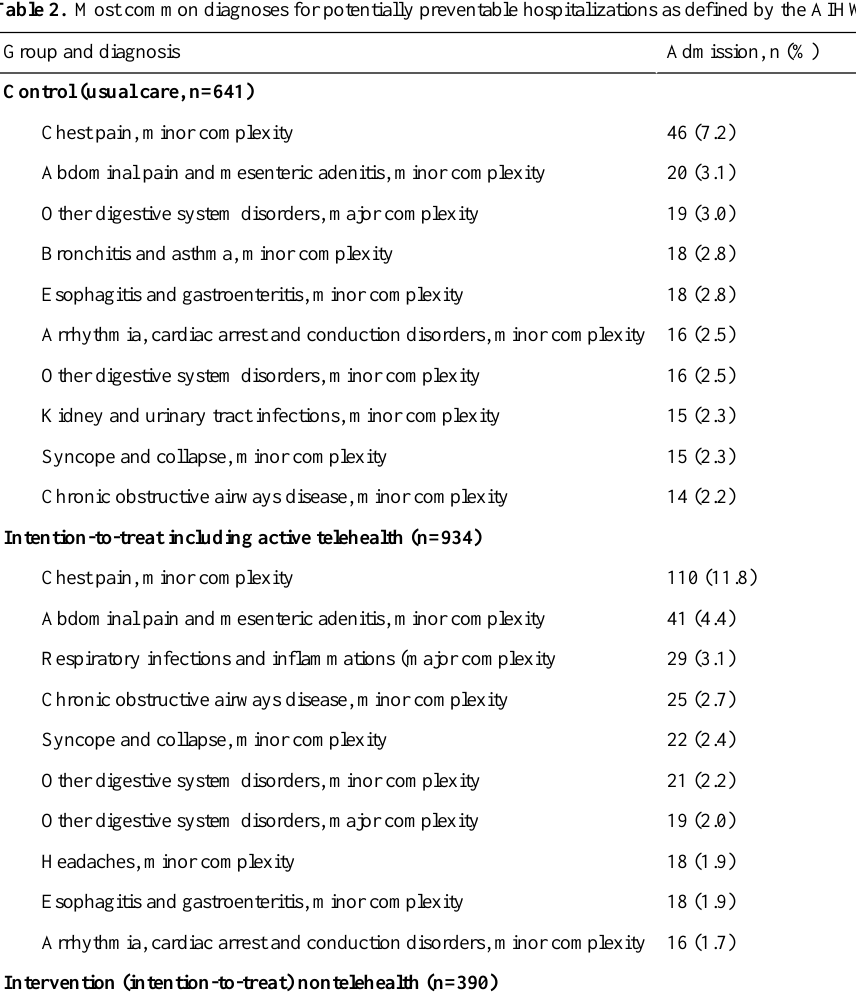
Table 2. Most common diagnoses for potentially preventable hospitalizations as defined by the AIHW within each group of MonashWatch patients. Control (usual care, n=641)